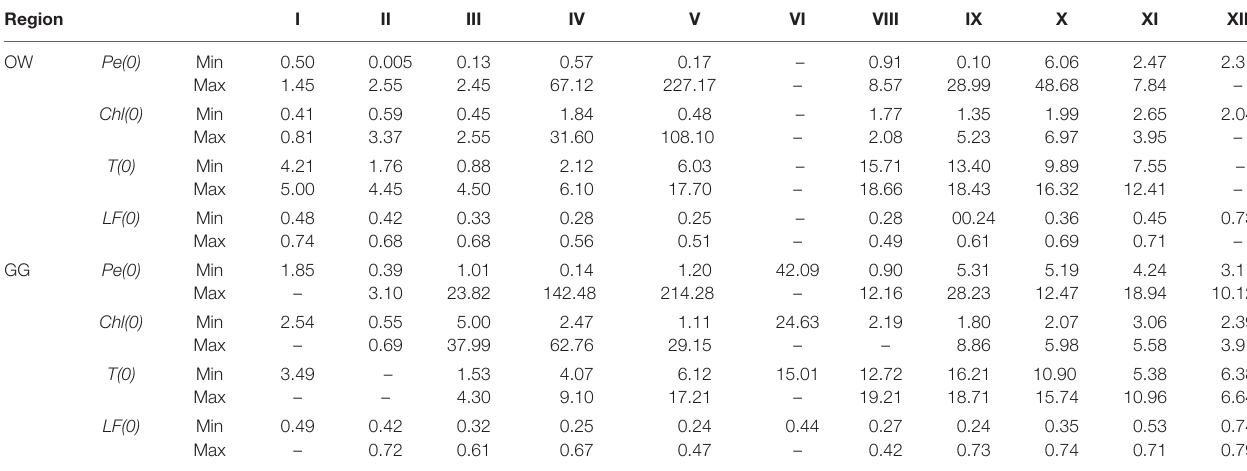
TABLE 1 | Monthly changes (Min–Max) of surface values of the hourly primary production − Pe(0) (mg C m − 3 h − 1 ), chlorophyll a concentration − Ca(0) (mg m − 3 ), temperature − T(0) ( ◦ C), and light factor − LF(0) (dimensionless) within 1993–2018 in the Baltic Proper (OW) and the Gulf of Gdansk (GG).